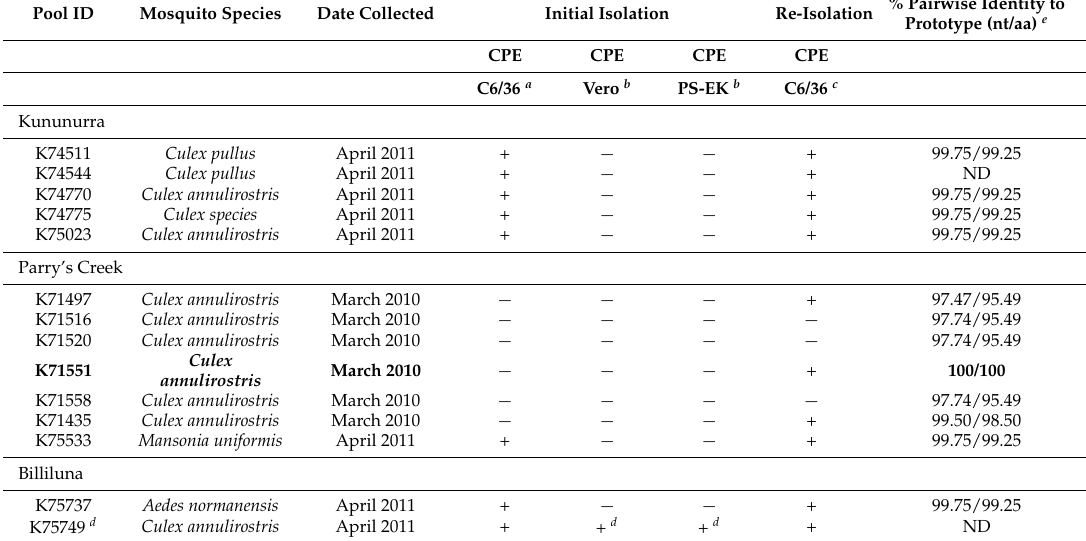
Table 1. Summary of mosquito pools that tested positive for PLV by RT-PCR